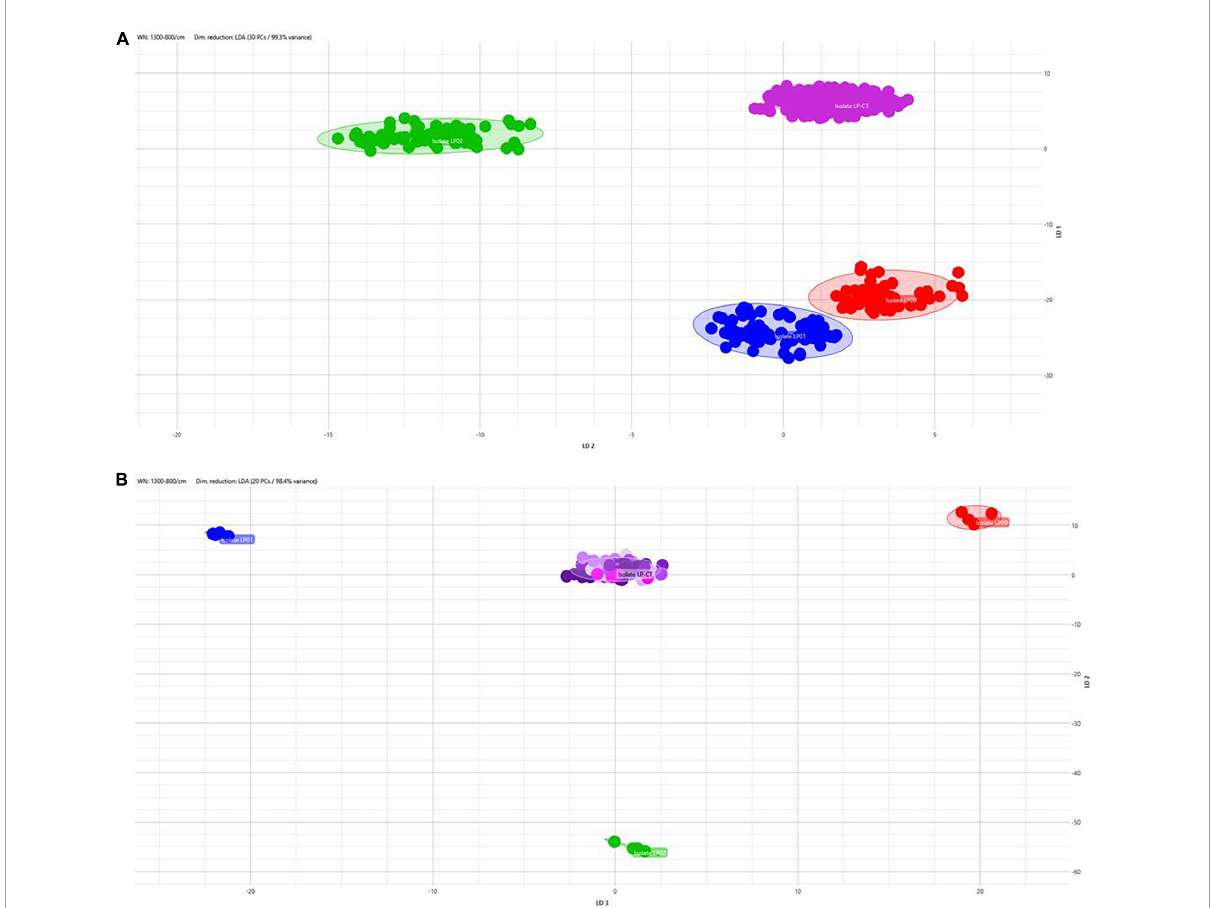
FIGURE4 (A) 2D scatterplot of all the spectra included in this study, including all the isolates and all the incubation protocols (scheme 2) and applying LDA analysis with 30 PCs (representing 99.3% of variance). Isolate LP-CT is depicted in violet, LP01 in blue, LP02 in green, and LP09 in red. Each geometric form represents an IRBT spectrum. (B) 2D scatterplot displaying the four isolates in the preparation broth 37 ◦ C (LP-CT with all its passages). Each isolate is represented by different colors (LP-CT in violet, LP01 in blue, LP02 in green, and LP09 in red). Different shades of color represent the culture steps, in a gradient from the oldest (lighter) to the newest (darker), and the final lyophilized sample is displayed in magenta. The scatterplot was created using LDA with 20 principal components (PCs), corresponding to 98.4% of